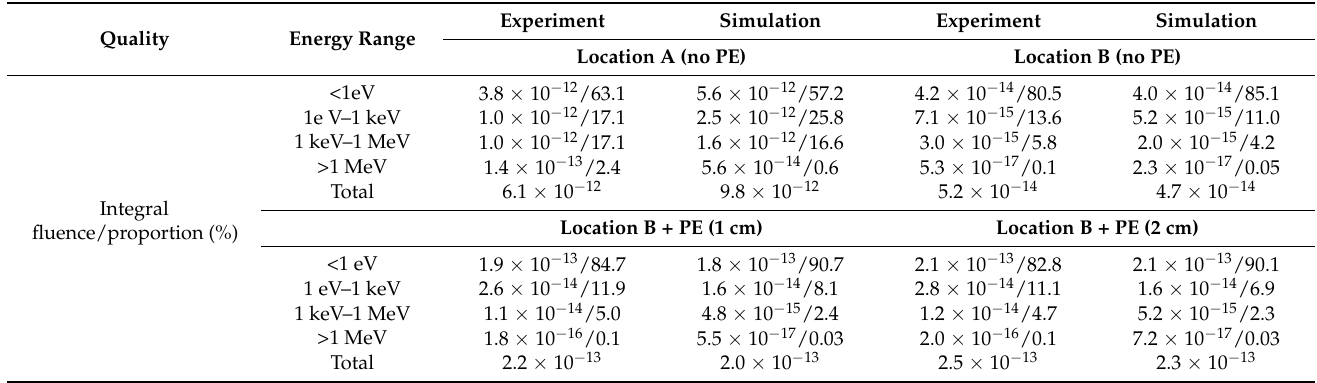
Table 1. Integral neutron fluence rate (n/cm 2 /proton) and their percentages in different en- ergy ranges.